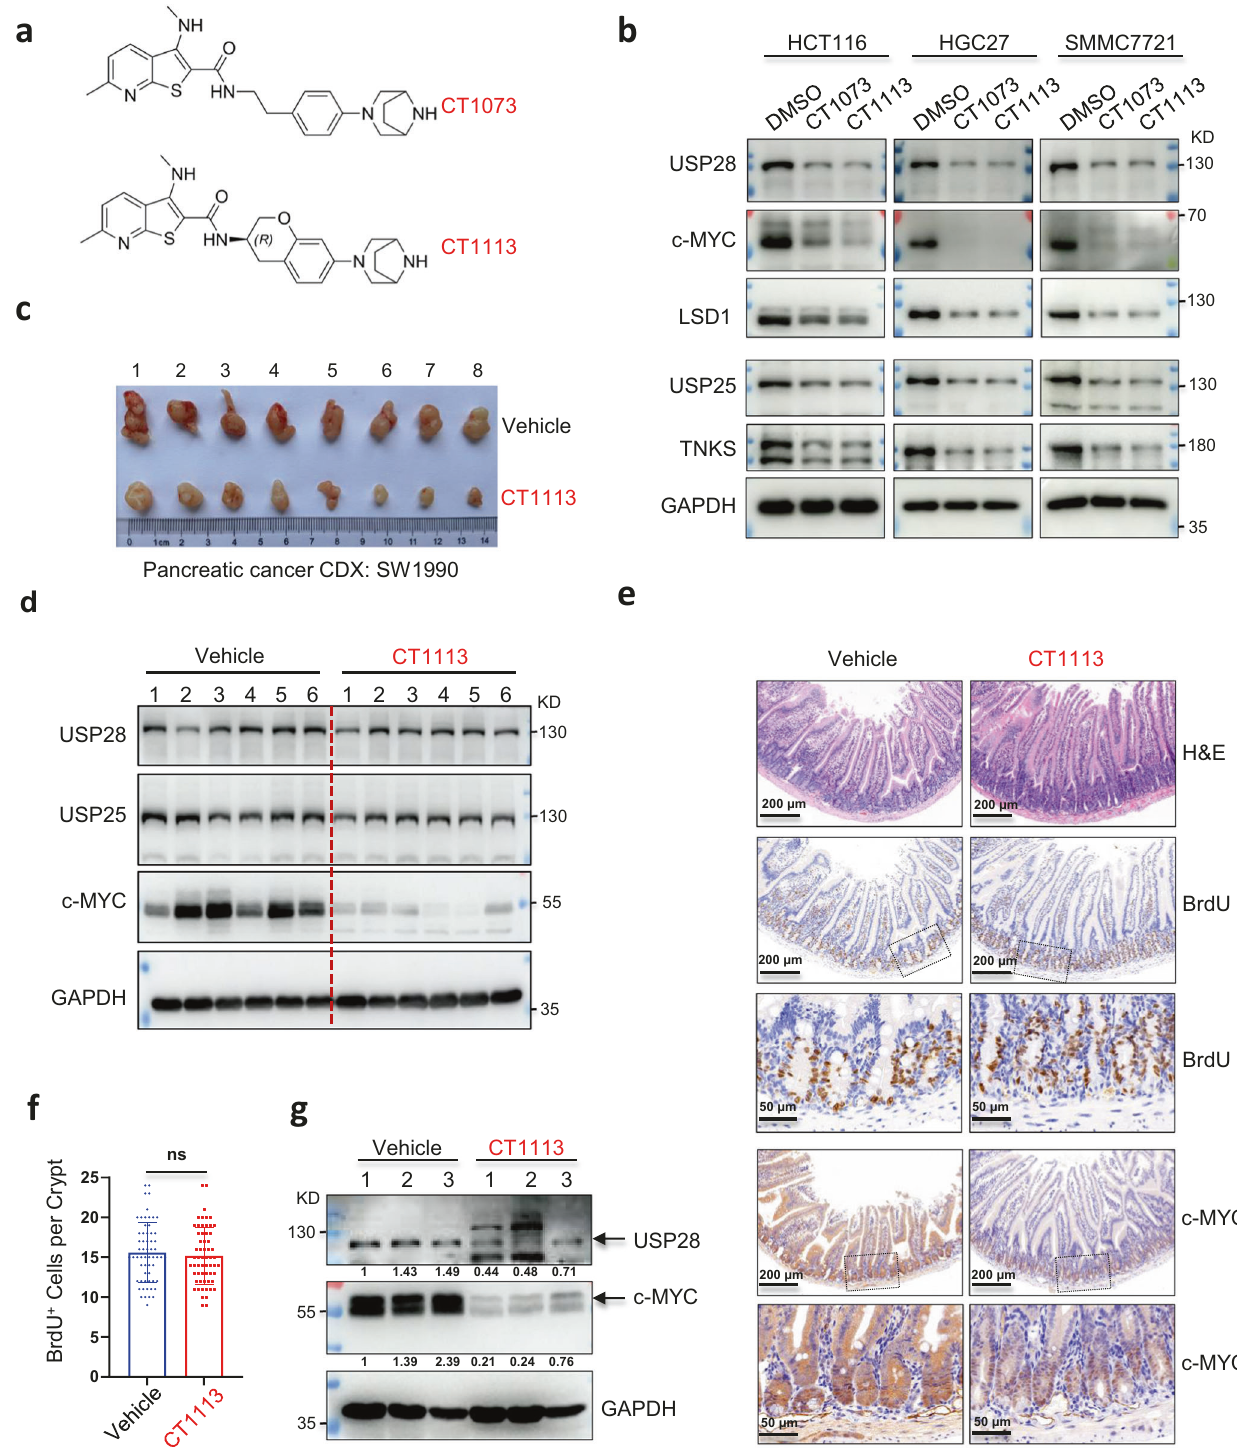
Fig. 1 Identi fi cation of USP28 inhibitors. a The chemical structures of CT1073 and CT1113. b Western blotting analysis of the indicated proteins in the cells treated with 500 nM CT1073 or CT1113 for 24 h. c The effect of CT1113 in a pancreatic cancer CDX model generated by inoculating SW1990 cells into Balb/c nude mice ( n = 8 mice per group). The photographs of the tumors are presented. d Western blotting analysis of the tumor samples shown in c . e Hematoxylin and eosin (H&E) staining and immunohistochemical staining of the small intestines from the vehicle control and CT1113 treated animals ( n = 3 mice per group). f . Quantitation of BrdU incorporation. The BrdU positive cells in the intestinal crypts ( e ) were counted and plotted. Student ’ s t- test: n.s. indicates no signi fi cant difference. g Western blotting analysis of USP28 and c-MYC levels in the intestine from control and CT1113-treated mice. The numbers are band intensities of USP28 or c-MYC relative to GAPDH which were further normalized against sample 1 in the control group